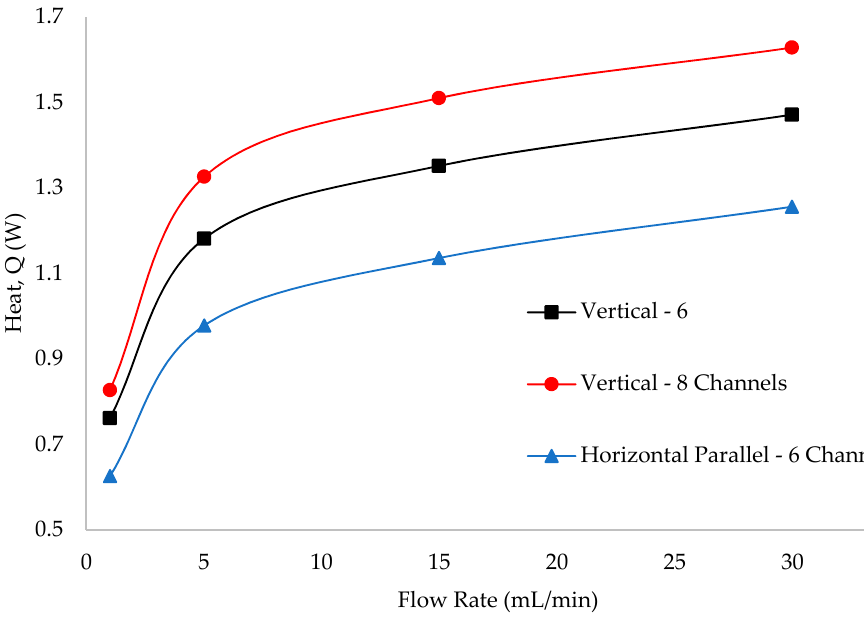
Figure 21. Heat transfer for three different configurations.